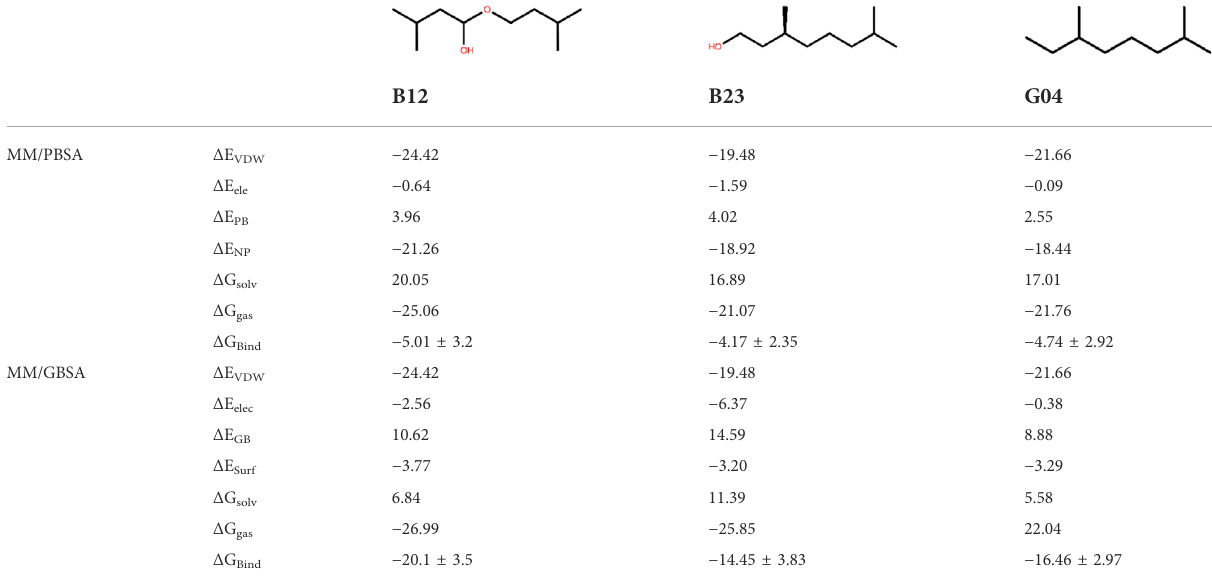
TABLE 2 Binding free energy and its components obtained by MM-PB/GBSA calculation for all